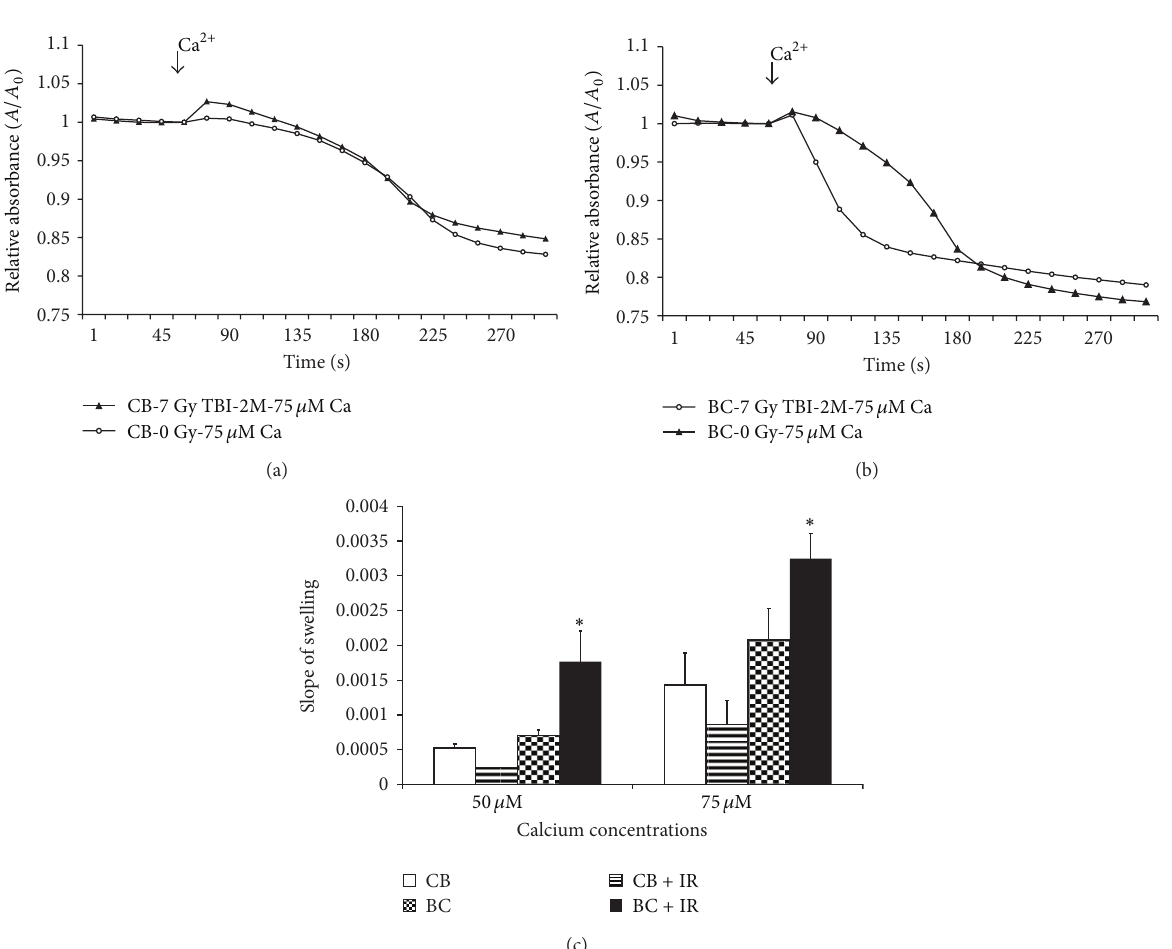
differed significantly between the 2 strains.